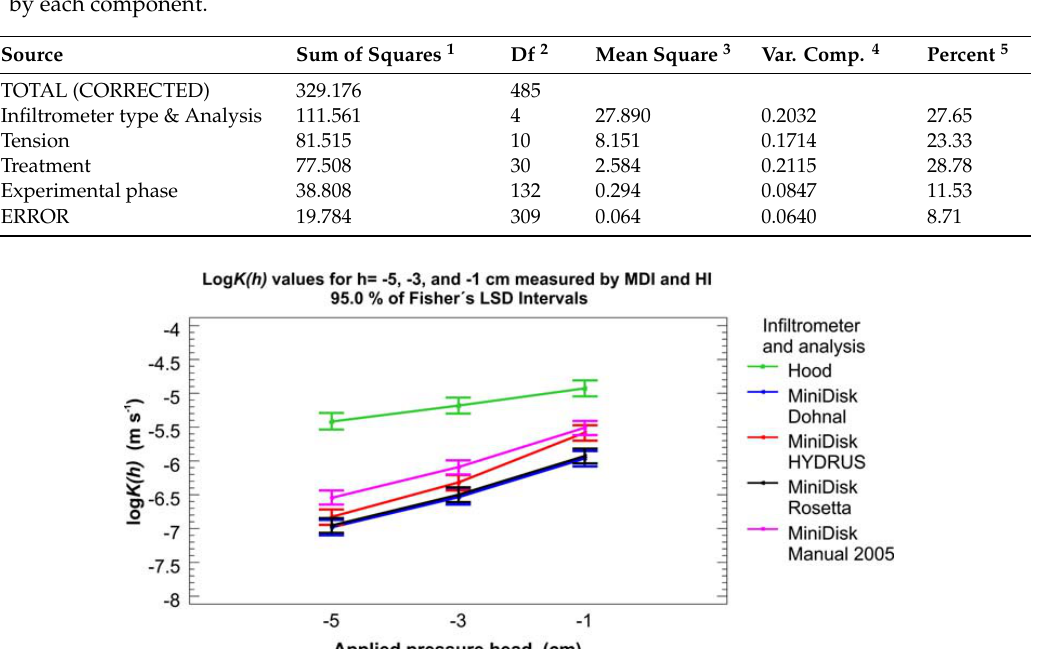
Table 4. Results of Variance component analysis evaluating factors contributing to total variability in log K(h); The columns show: 1 decomposition of the sum of squared deviations around the grand mean, 2 degree of freedom associated with each sum of squares, 3 sums of squares divided by their degrees of freedom, 4 estimated variance components and 5 percentage of the total process variance represented by each component.